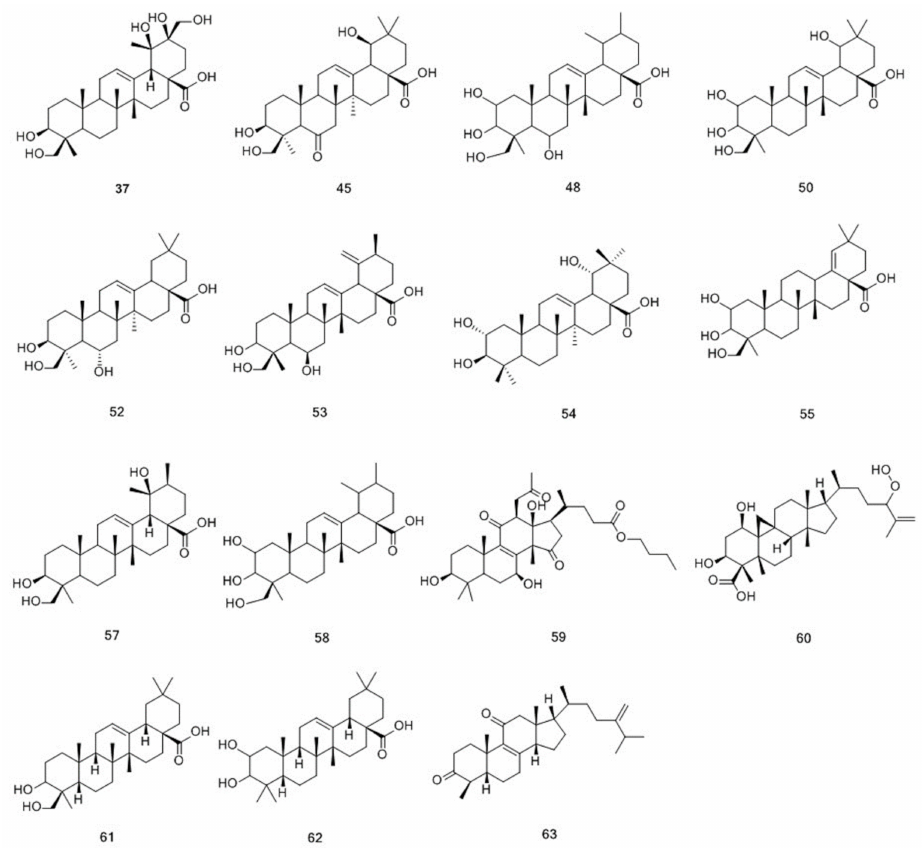
Figure 4. Chemical structures of triterpenoids identified in M. citrifolia and M. o ffi